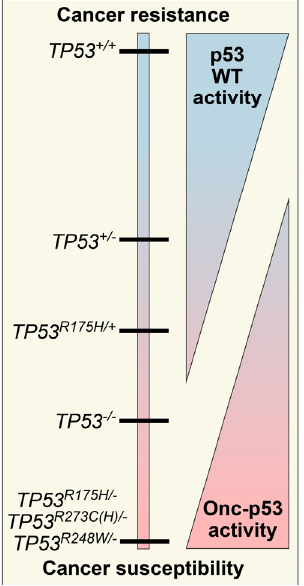
Figure 1. The spectrum of protection against cancer provided by WT p53. As copies of WT p53 ( TP53 +/+ ) are lost, cancer protection decreases. When oncomorphic mutations are acquired, cancer susceptibility is